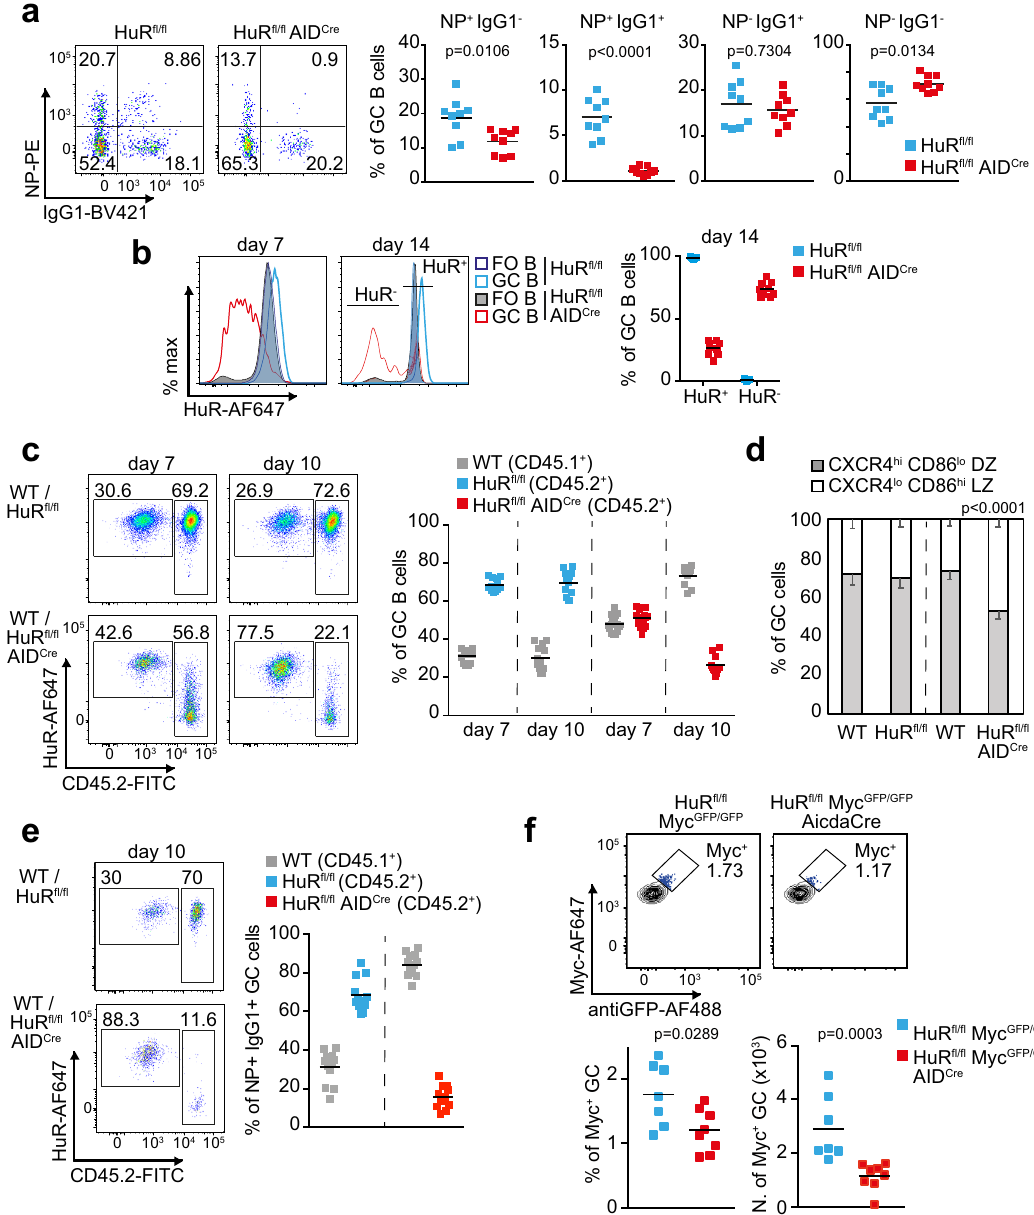
Fig. 3 HuR is required for the expansion of antigen-speci fi c GC B cells. a Pseudo-colour plot of NP-speci fi c GC B cells in the spleen of HuR fl / fl and HuR fl / fl AID Cre mice at day 10 after immunisation with NP-KLH in alum. Right panels show the percentage of GC B cells based on surface expression or not of IgG1 and binding of NP antigen. Data are representative from 1 of the 3 independent experiments performed, n = 9 mice per group and experiment, two-sided Mann – Whitney test). b Histograms showing HuR expression in splenic FO and GC B cells from HuR fl / fl and HuR fl / fl AID Cre mice at day 7 and day 14 after immunisation. Right panel, the percentage of HuR + and HuR − GC B cells in HuR fl / fl and HuR fl / fl AID Cre mice at day 14 after immunisation (data representative from 1 of the 3 independent experiments performed ( n = 9 mice per group and experiment)). c Pseudo-colour plots and analysis of the proportion of CD45.2 − and CD45.2 + GC B cells in draining LNs of BM chimera mice (WT CD45.1 + /HuR fl / fl CD45.2 + or CD45.1 + /HuR fl / fl AID Cre CD45.2 + , ratio 1:3) after immunisation with NP-KLH in alum. d Percentage of WT (CD45.2 − ) GC B cells and HuR fl / fl or HuR fl / fl AID Cre (CD45.2 + ) GC B cells expressing the cell surface markers of DZ and LZ GC B cells in BM chimera mice. Data are presented as mean values + / − SEM. e Analysis of the proportion of CD45.2 − and CD45.2 + NP-speci fi c IgG1 + GC B cells in mice shown in c . Data in c – e are from n = 12 or 16 mice per group depending on the genotype and the day of analysis. Data in e are from n = 12 mice per group. Two-sided Mann – Whitney test in d . f Myc + GC B cells in draining LNs of HuR fl / fl Myc GFP/GFP and HuR fl / fl Myc GFP/GFP AID Cre mice at day 7 after immunisation with NPKLH in alum (s.c.). Top panels, representative contour plots of Myc staining and GFP detection (previously gated on CD19 + IgD − CD95 + CD38 − cells). Bottom panels, percentage and number of Myc + GC B cells ( n = 7 (HuR fl / fl ) or n = 8 (HuR fl / fl AID Cre ) mice, two-sided Mann – Whitney test). Source data are provided as a Source data fi